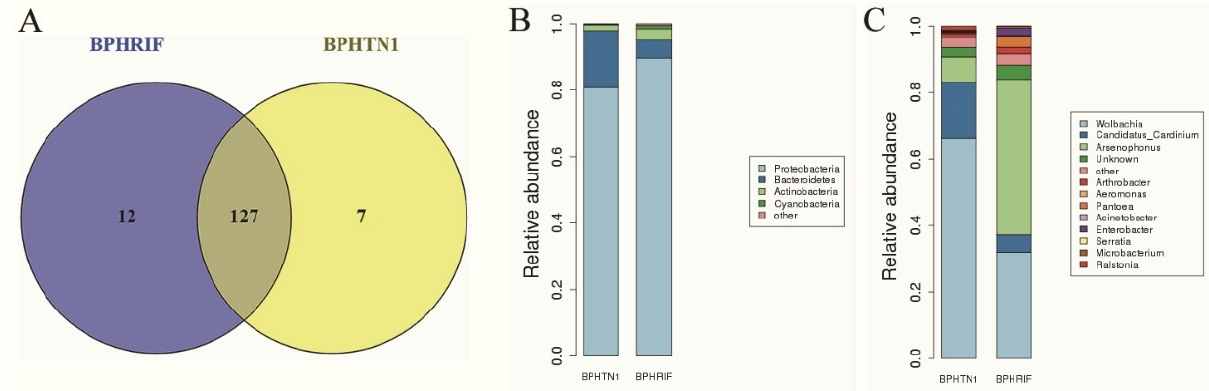
Figure 2. The changes of bacterial communities of BPH. ( A ) Venn diagram shows the similarities and differences of the bacterial communities of BPH feed on the rice treated with/without rifampicin. ( B ) Relative abundance of the bacterial communities on phylum level. ( C ) Relative abundance of the bacterial communities on genus level. Note: the abbreviation BPHRIF and BPHTN1 in ( A – C ) indicated the sample names of 16S rRNA sequencing; the ordinate indicates the relative abundance percentage; one color represents a species, the color block length represents the relative abundance ratio of the species; the part with abundance less than 1% is merged into Others, Unknown OTUs that are not taxonomically annotated.